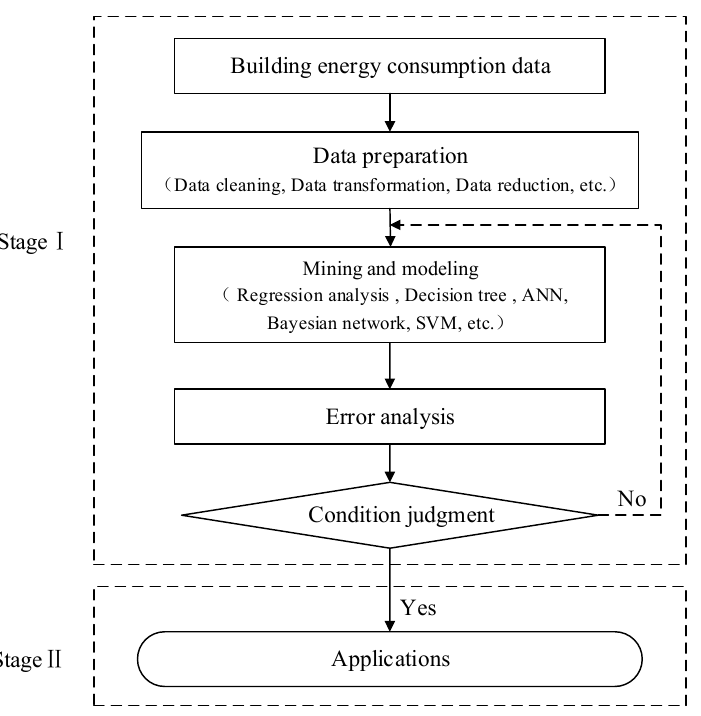
Figure 2. Flow chart of load forecasting.